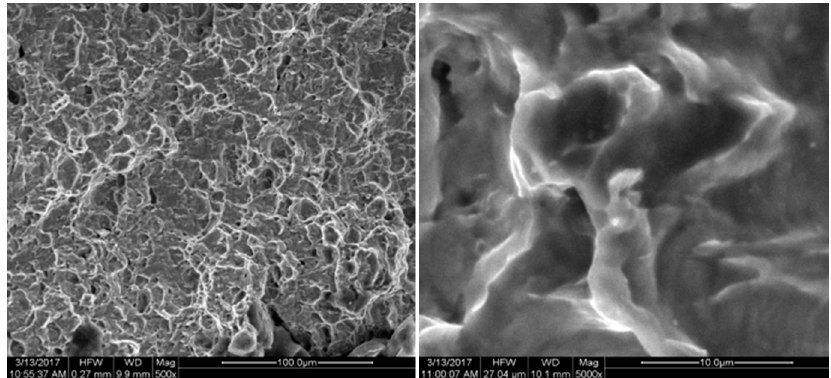
Figure 16. X-axis fracture under the tension speed of 40 μ m/min.